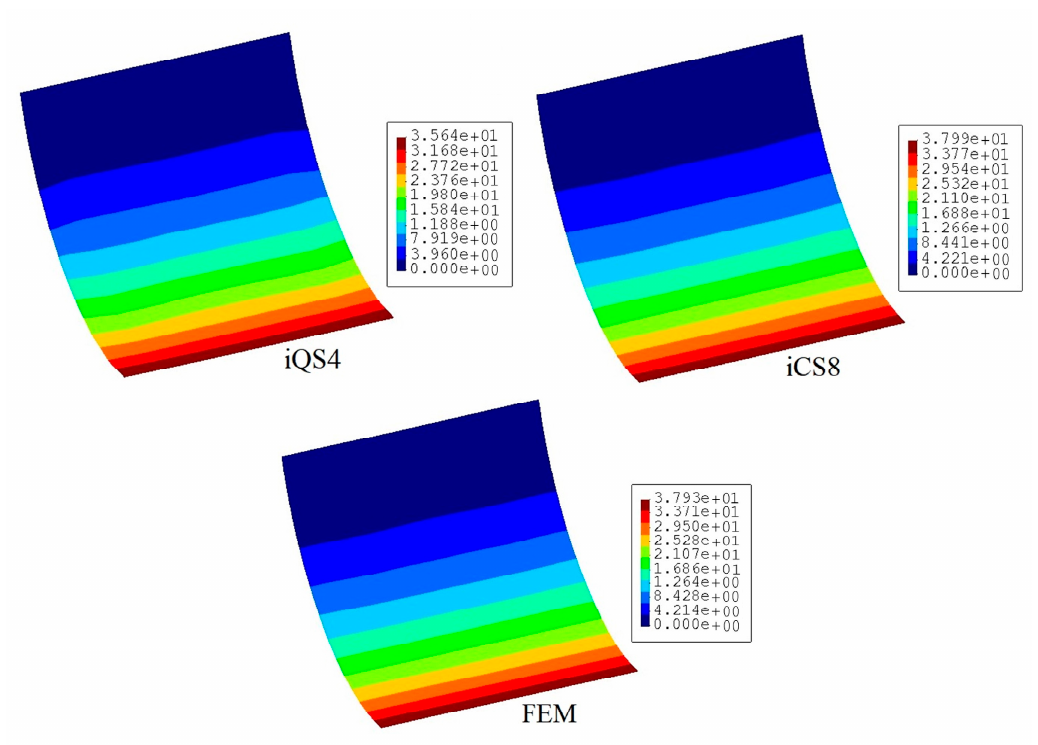
Figure 16. Contours of total displacement [mm] for the damaged condition of the curve plate.